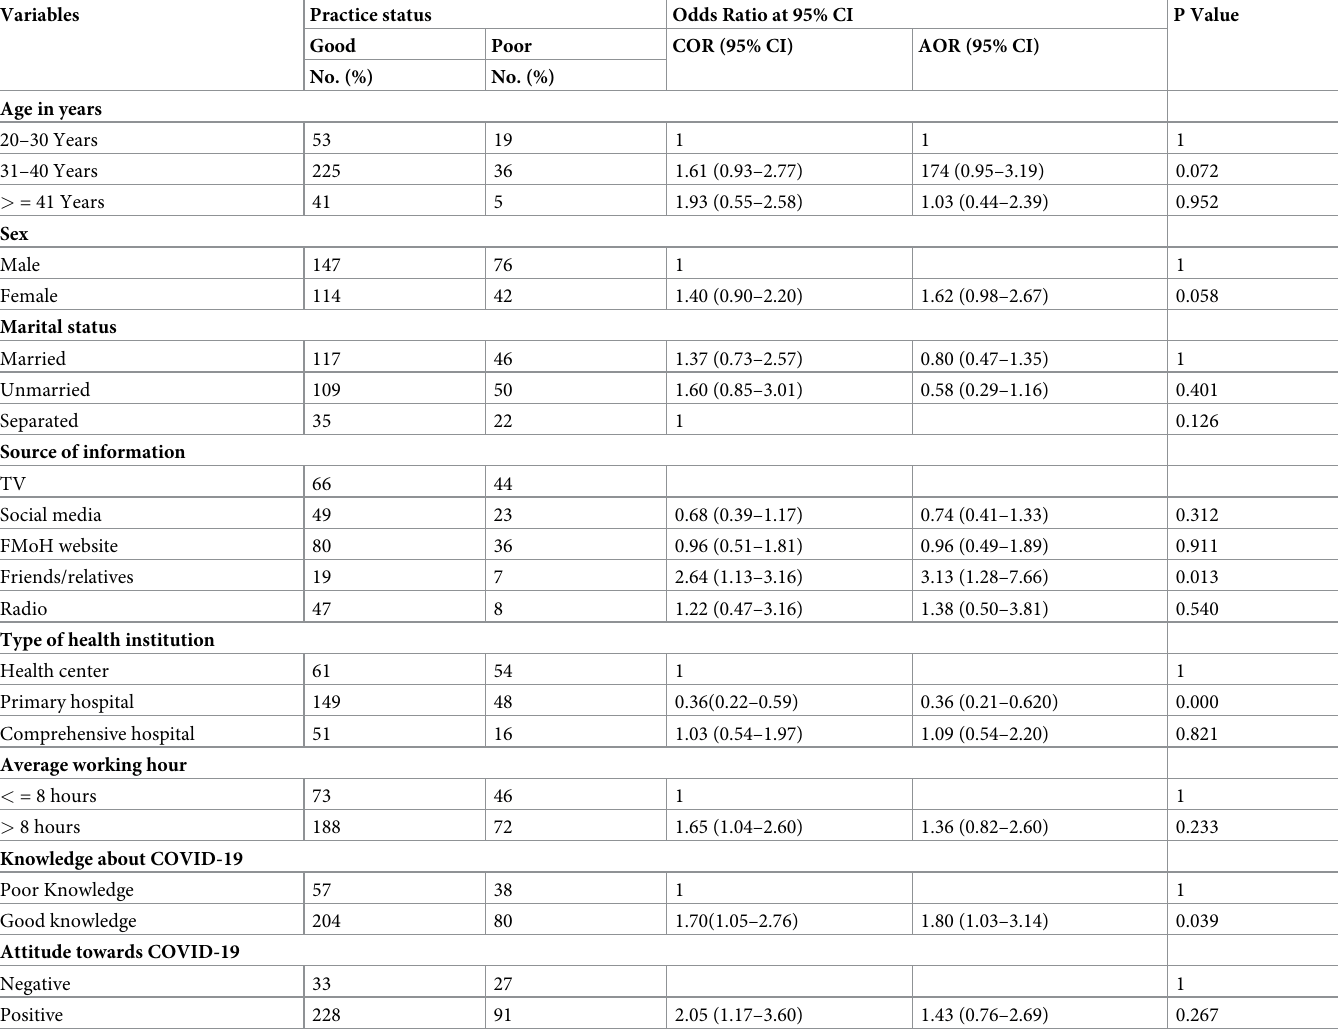
Table 4. Factors associated with preventive practice of COVID-19 among health care workers in Silte zone, southern Ethiopia, 2020.